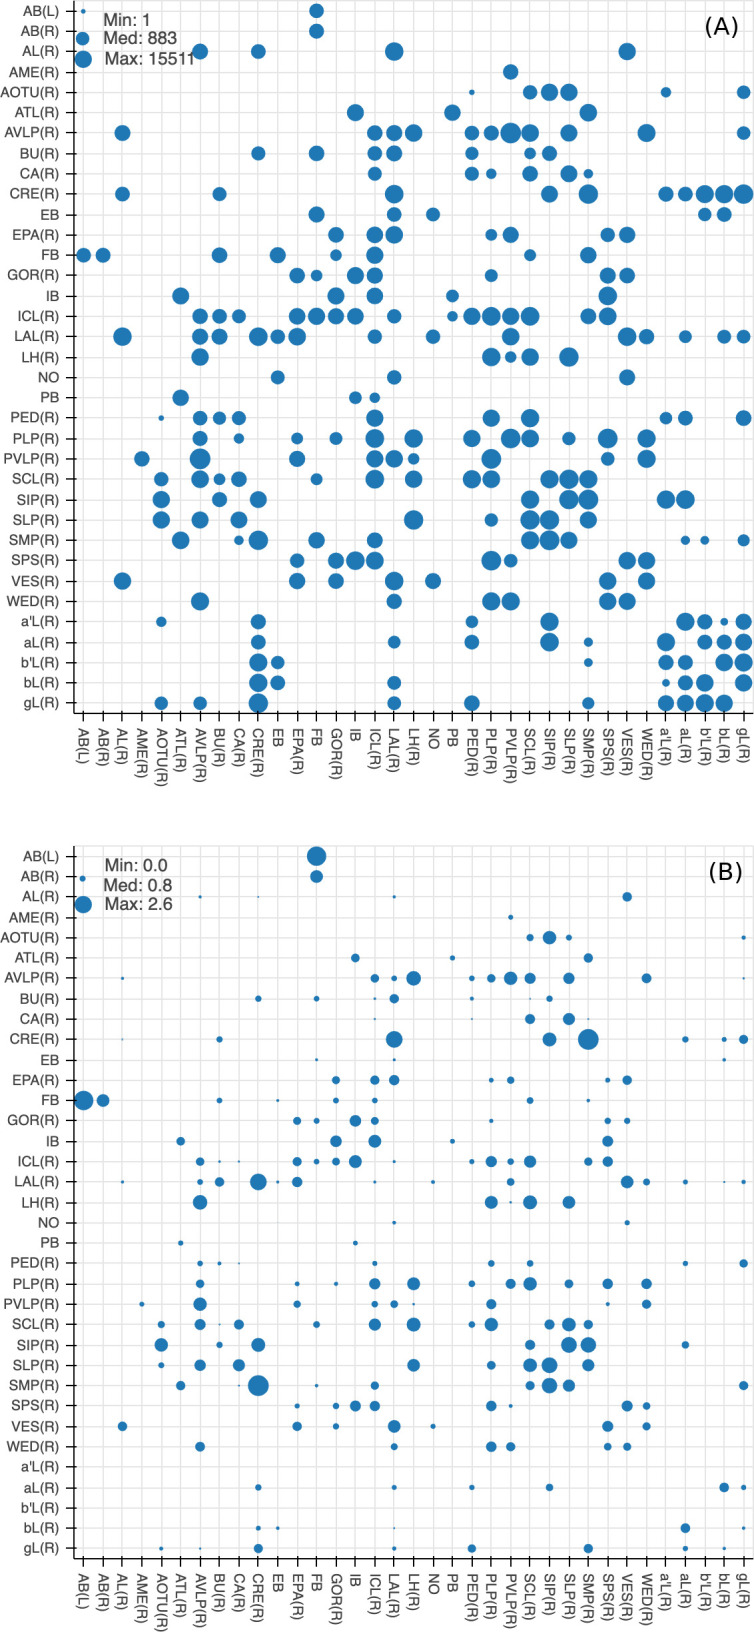
Quality checks of the brain compartments.(A) Areas of the boundaries (in square microns) between adjacent neuropils, indicated on a log scale. (B) The number of excess crossings normalized by the area of neuropil boundary. Larger dots indicate a more uncertain boundary. Data available in Figure 8—source data 1.Figure 8—source data 1.Data for Figure 8.Column A: index number; column B: first ROI name; column C: second ROI name; column D: boundary area in square microns; column E: number of neurons crossings; column F: number of distinct neurons that cross; column G: (crossings - number of neurons) per area.